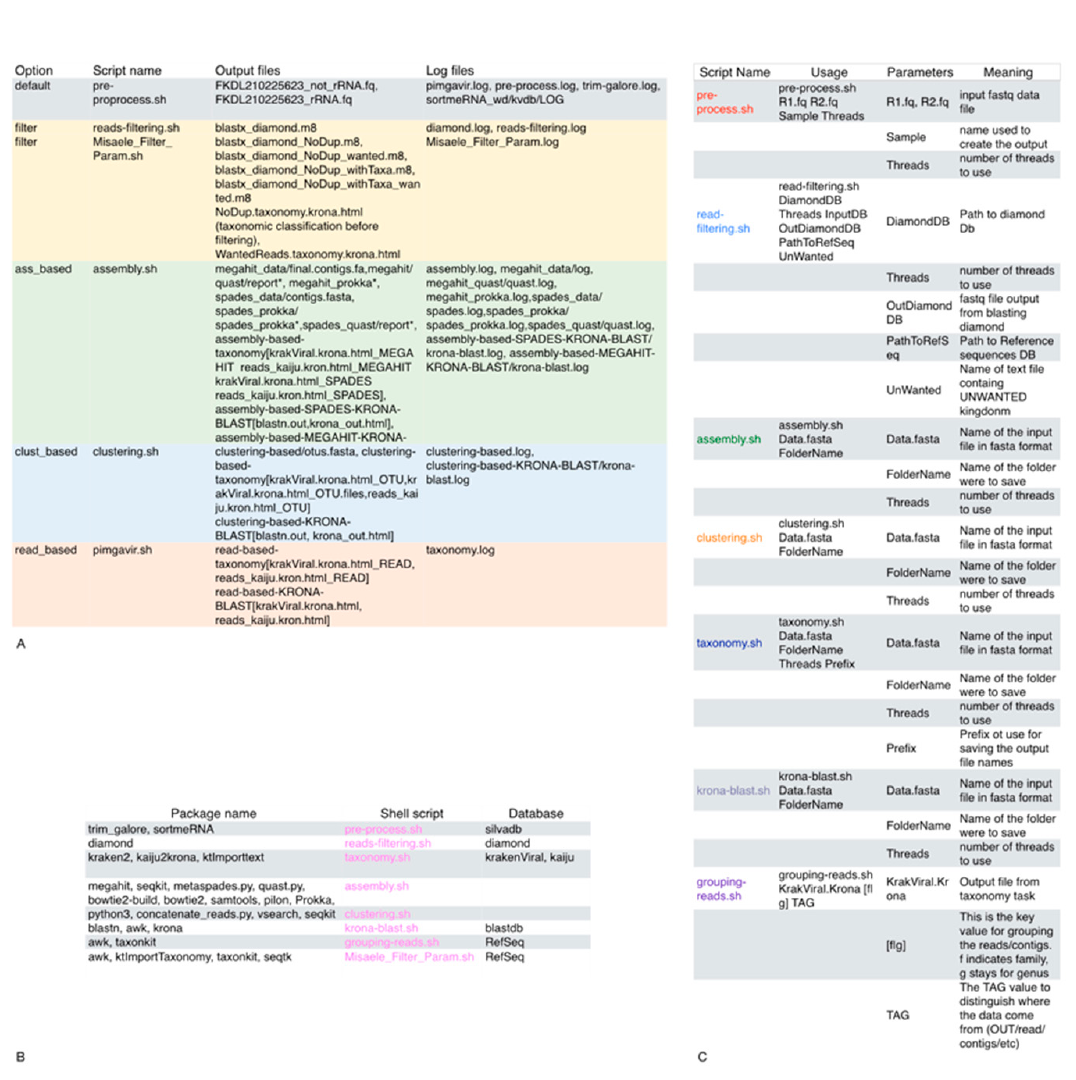
Figure 1. PIMGAVir pipeline. ( A ) PIMGAVir flowchart showing the pre-processing task, the filter- ing option, the execution of the three strategies and the taxonomic classification. ( B ) Example of the data structure organization for the ass_based strategy. ( C ) Simplification of the PIMGAVir system architecture.